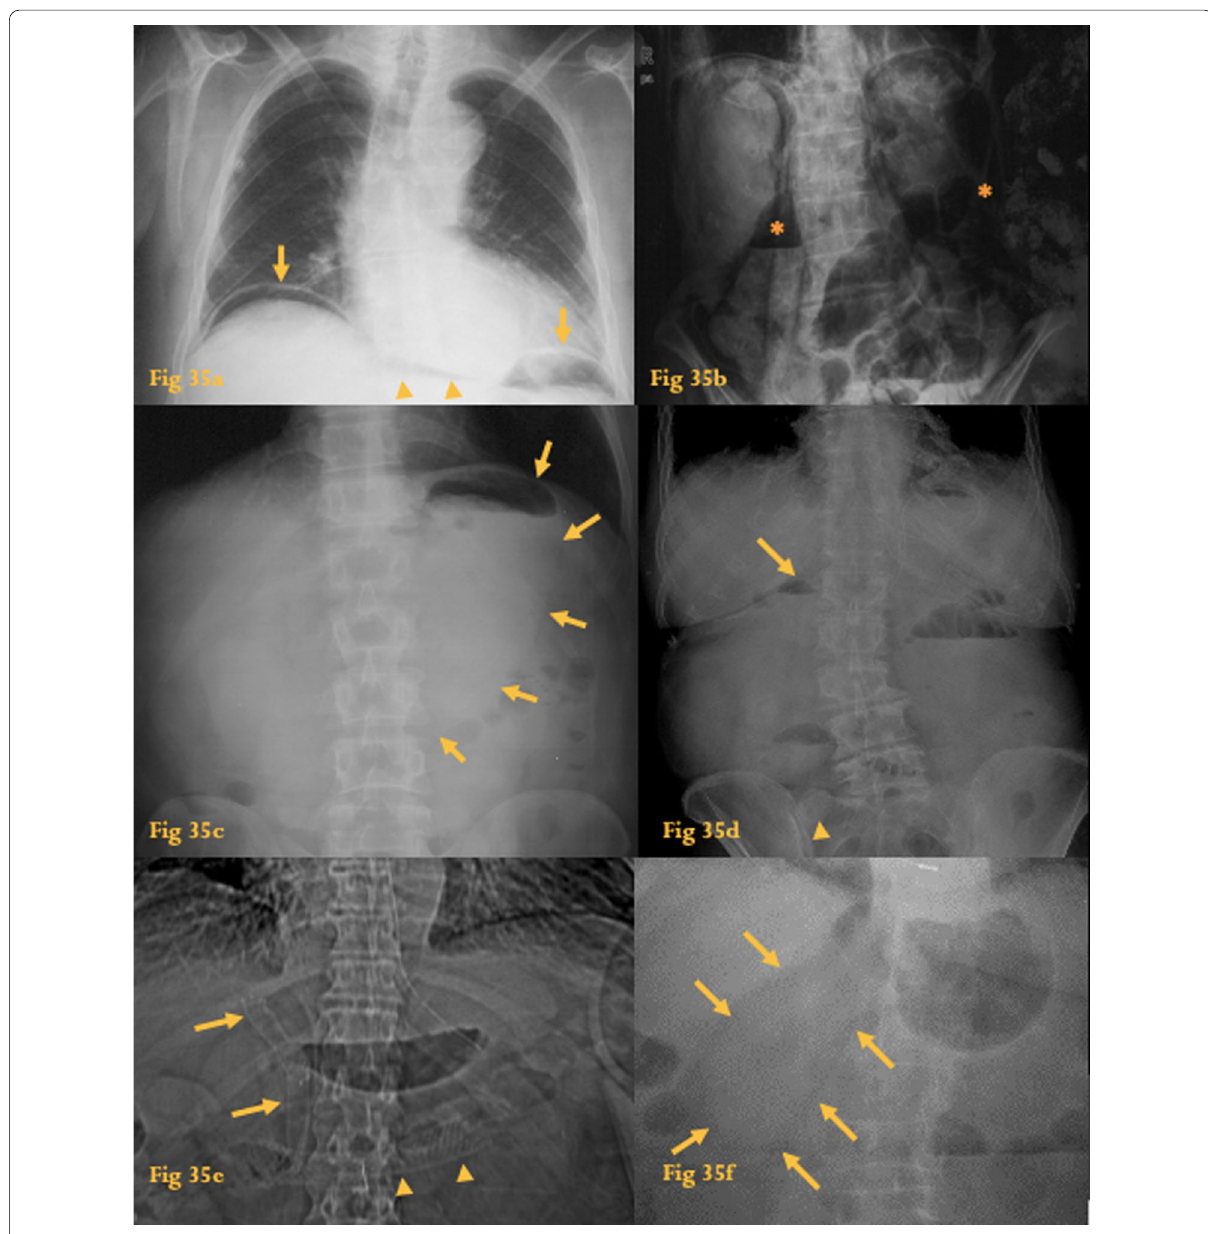
Fig. 35 Indirect signs of duodenal disease on X‑ray. Chest radiograph ( a ) shows a small amount of gas beneath the diaphragm (arrows) and the continuous diaphragm sign is also seen (arrowheads). At surgery, a perforated duodenal bulb ulcer was identified. Abdominal radiograph ( b ) shows pneumoretroperitoneum (asterisks) after duodenal rupture following ERCP. Abdominal radiograph ( c ) shows a stomach with augmented volume (arrowheads)—gastric outflow obstruction caused by multiple polyps of the duodenum in a patient with juvenile polyposis. Abdominal radiograph ( d ) shows an air‑fluid level in the gallbladder (arrow) and a gallstone at the right iliac fossa (arrowhead), indicative of a gallstone ileus, because of a cholecystoduodenal fistula. Abdominal radiograph ( e ) shows a large horizontal prosthesis in the upper abdomen (arrowheads) and two smaller vertical prosthesis (arrows) in the horizontal and descending duodenum, which were a palliative treatment for an obstructive duodenal adenocarcinoma. Abdominal radiograph ( f ) shows an intraluminal soft‑tissue density at D2. This was a gastric GIST prolapsing into the